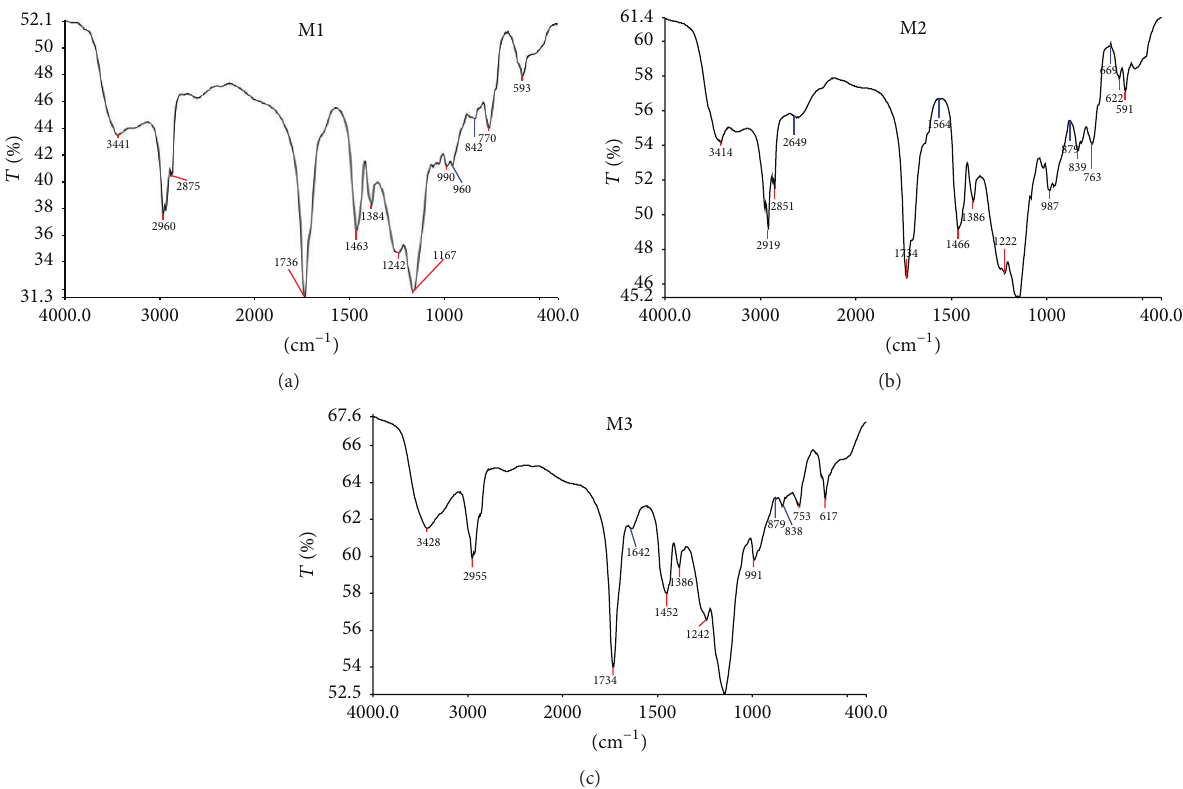
Figure 1: FTIR spectrum of the prepared terpolymers M1, M2, and M3.